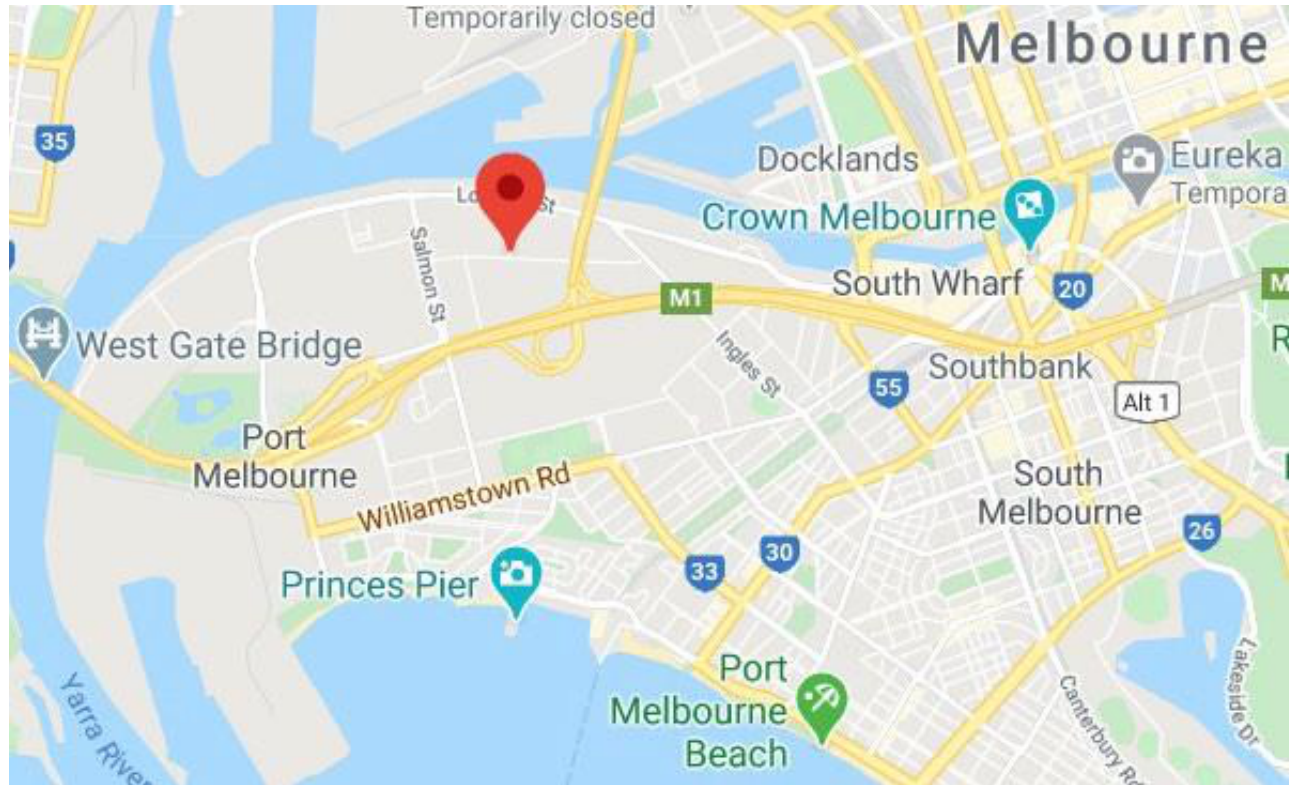
Figure 1. Turner street map, Source: (htttps://www.google.com/maps (accessed on 18 October 2020)).